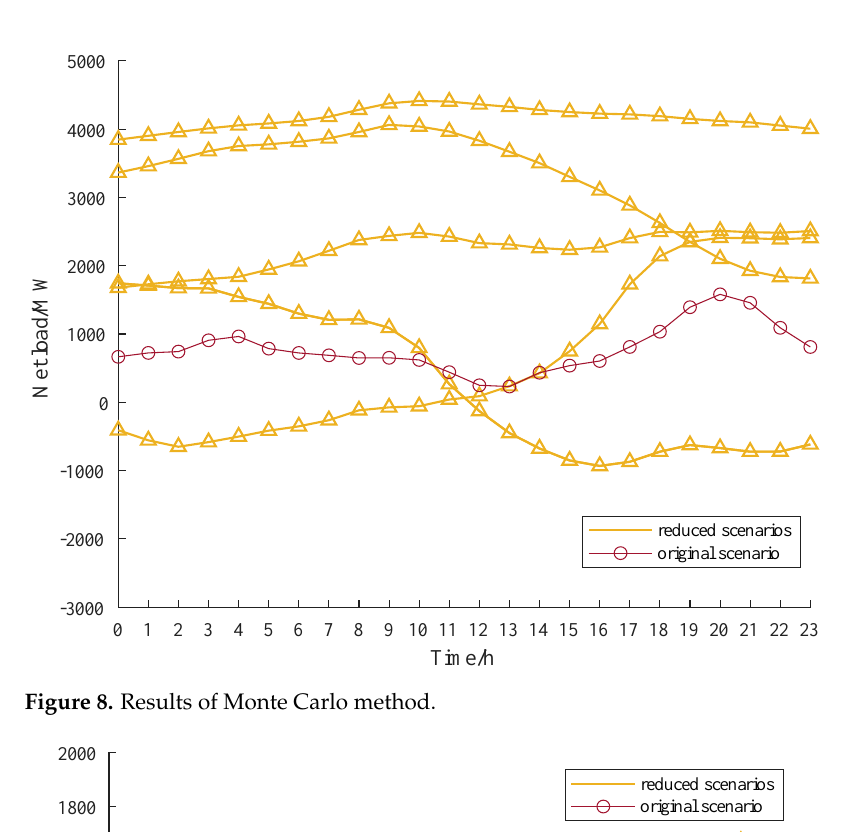
Figure 10. Results of proposed approach . In order to illustrate the advantages of the proposed approach, the Monte Carlo sam- pling (MCS) method is carried out. The time autocorrelation σ , average offset rate µ , and climbing similarity P e of the two methods are calculated, as shown in Table 6. Table 6. Results of evaluation indexes . Method